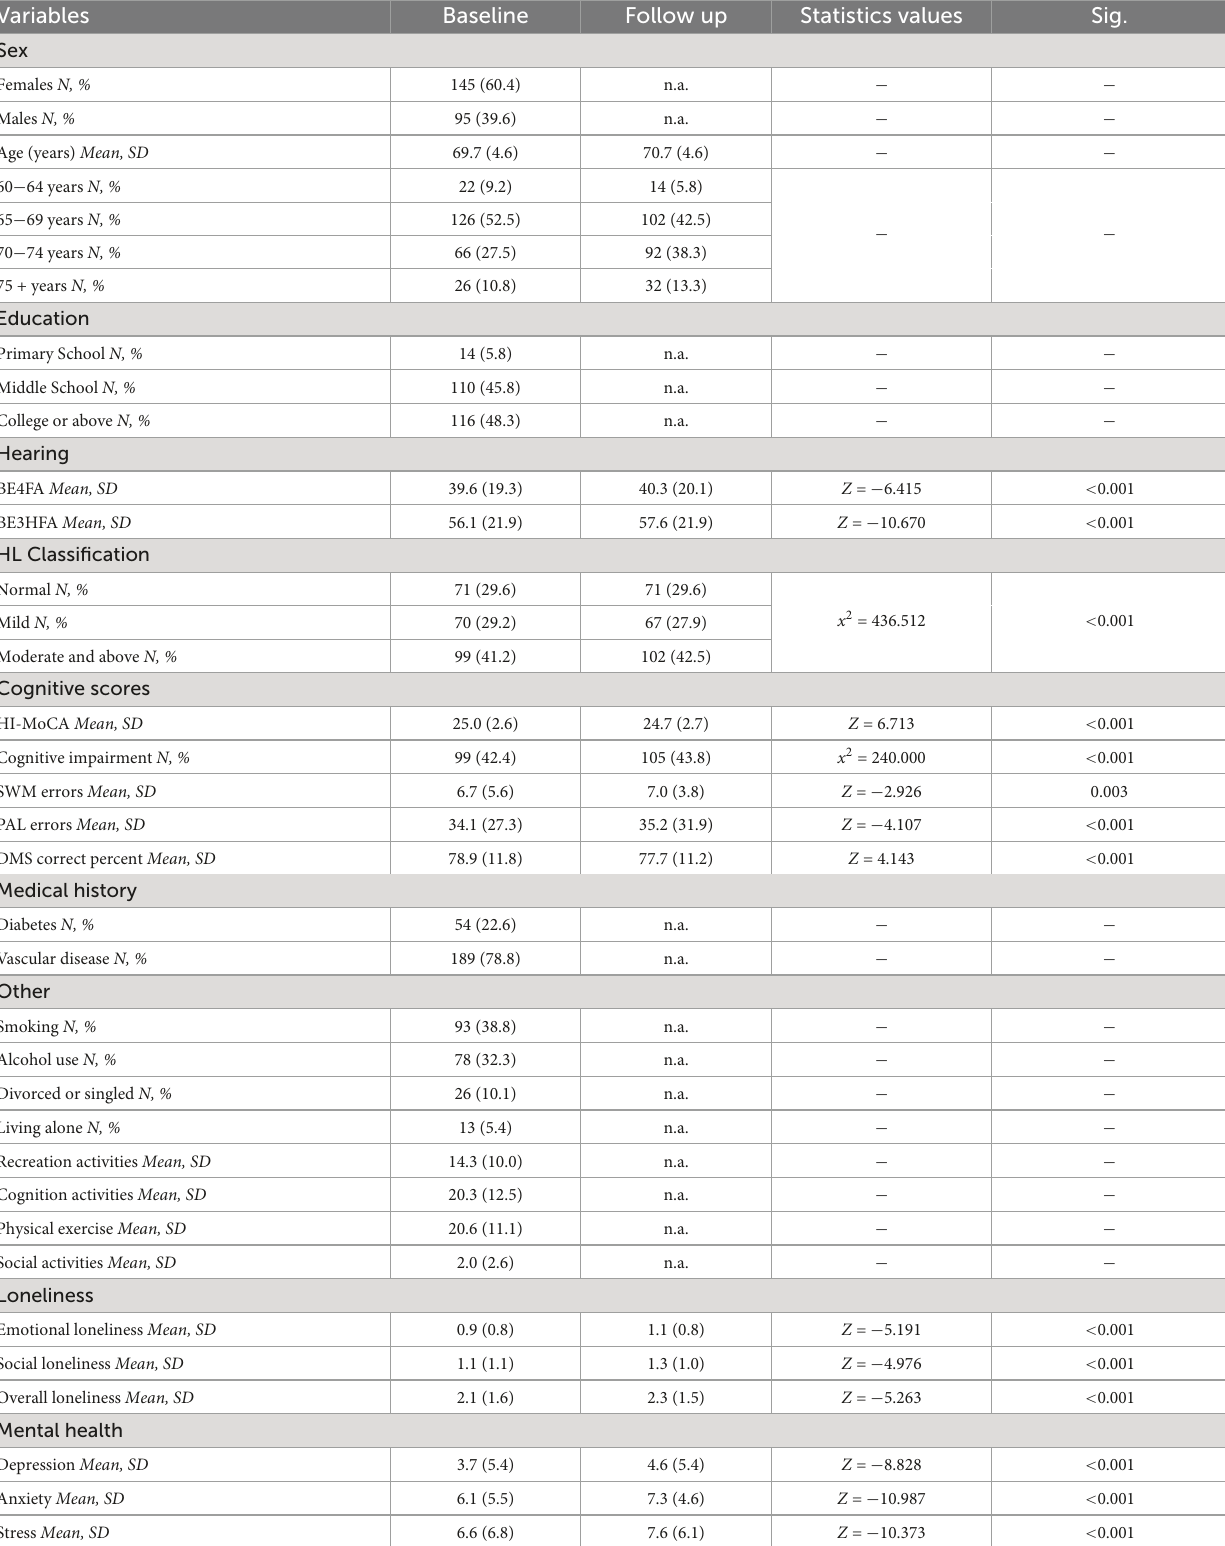
TABLE 1 Characteristics of the participants ( n = 240) at baseline and 12 month follow-up. Variables Baseline Follow up Statistics values